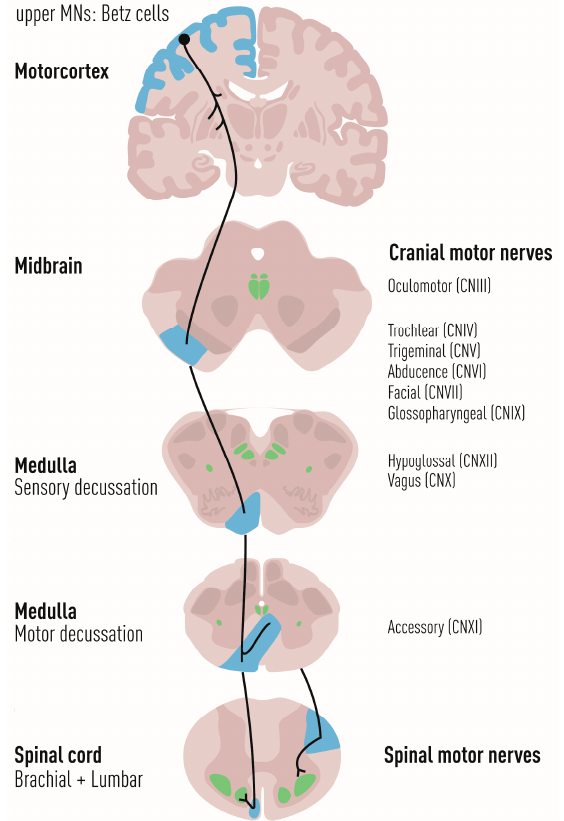
Figure 2. The upper motor system in humans and its connectivity with the lower motor system. Upper motor neurons are large pyramidal cells in the motor cortex, that are called Betz cells (blue). Their axons project through the corticospinal tract and innervate the nuclei of different lower motor neurons in the brainstem and spinal cord (green). Upper motor neurons are vulnerable to degeneration in ALS. Lower motor neurons are responsible for voluntary control of skeletal muscles and are vulnerable in ALS to different degrees.